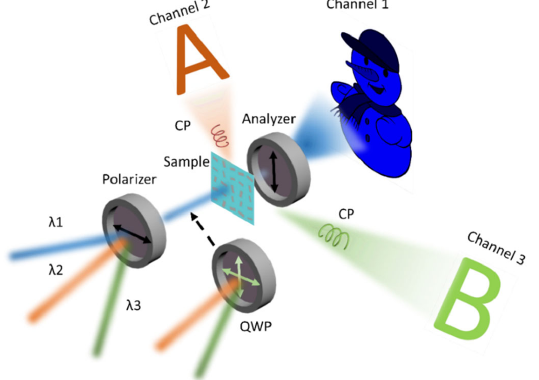
Figure 1. Operation schematic of three ‐ channel metasurface for three wavelengths holography and nanoprinting. The metasurface is composed of TiO 2 nanobricks with four kinds of structure and different orientation angles. The three images are displayed on three channels respectively.